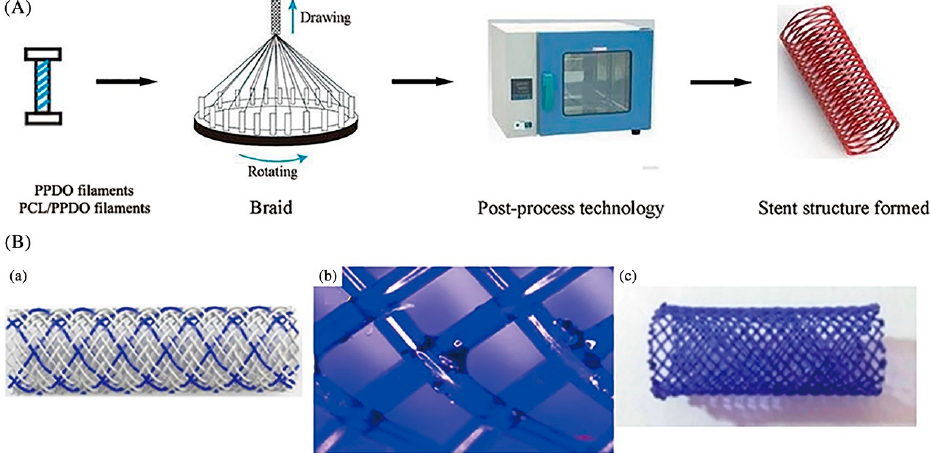
Figure 1. The braiding process of a biodegradable stent (BBS). ( A ) Scheme of stent production. ( B ) ( a ) geometrical model; ( b ) bond at the interlacing point with PCL/PPDO composite filament and PPDO monofilament; ( c ) sample [40], Copyright © 1999–2022 John Wiley & Sons, Inc .